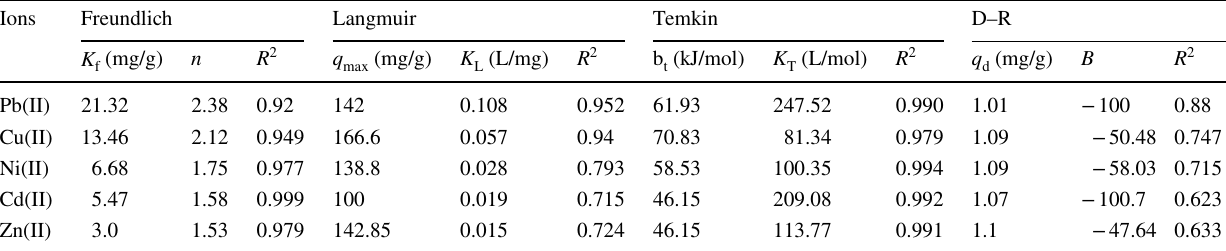
Table 4 Langmuir, Freundlich, Temkin and D–R models parameters for the biosorption of M(II) onto chitin